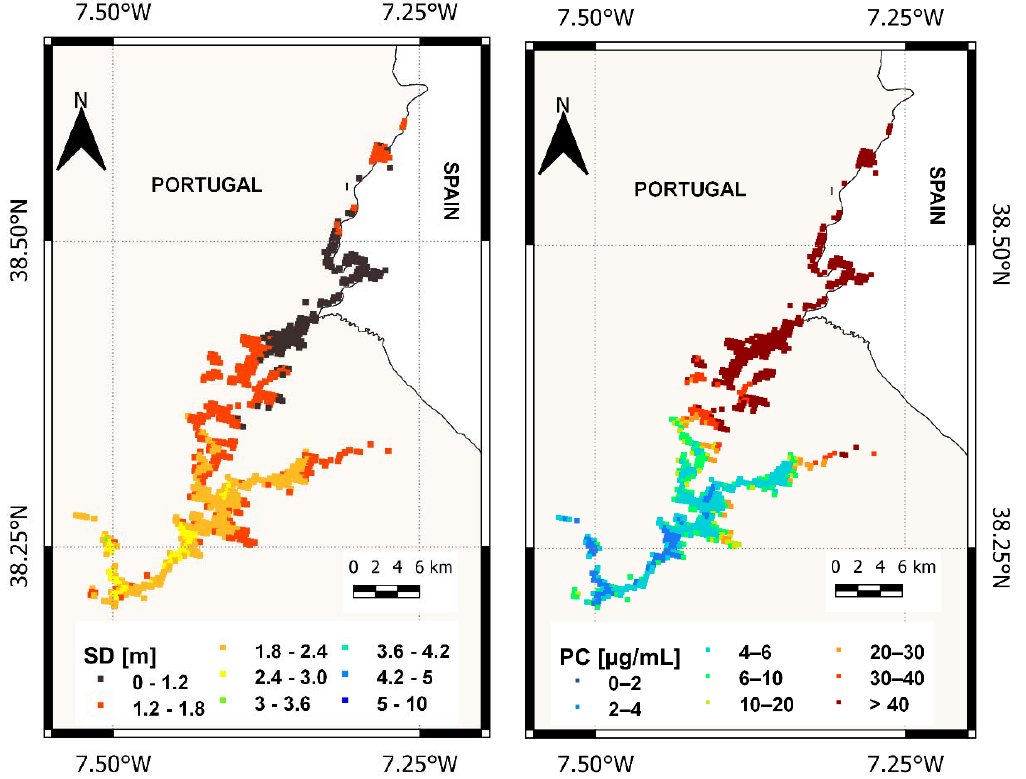
Figure 17. Above are the OWT ( left ) and Chl-a ( right ) maps on 26 September 2017 in the Alqueva reservoir. Below are the SD ( left ) and PC ( right ) maps for the same day.